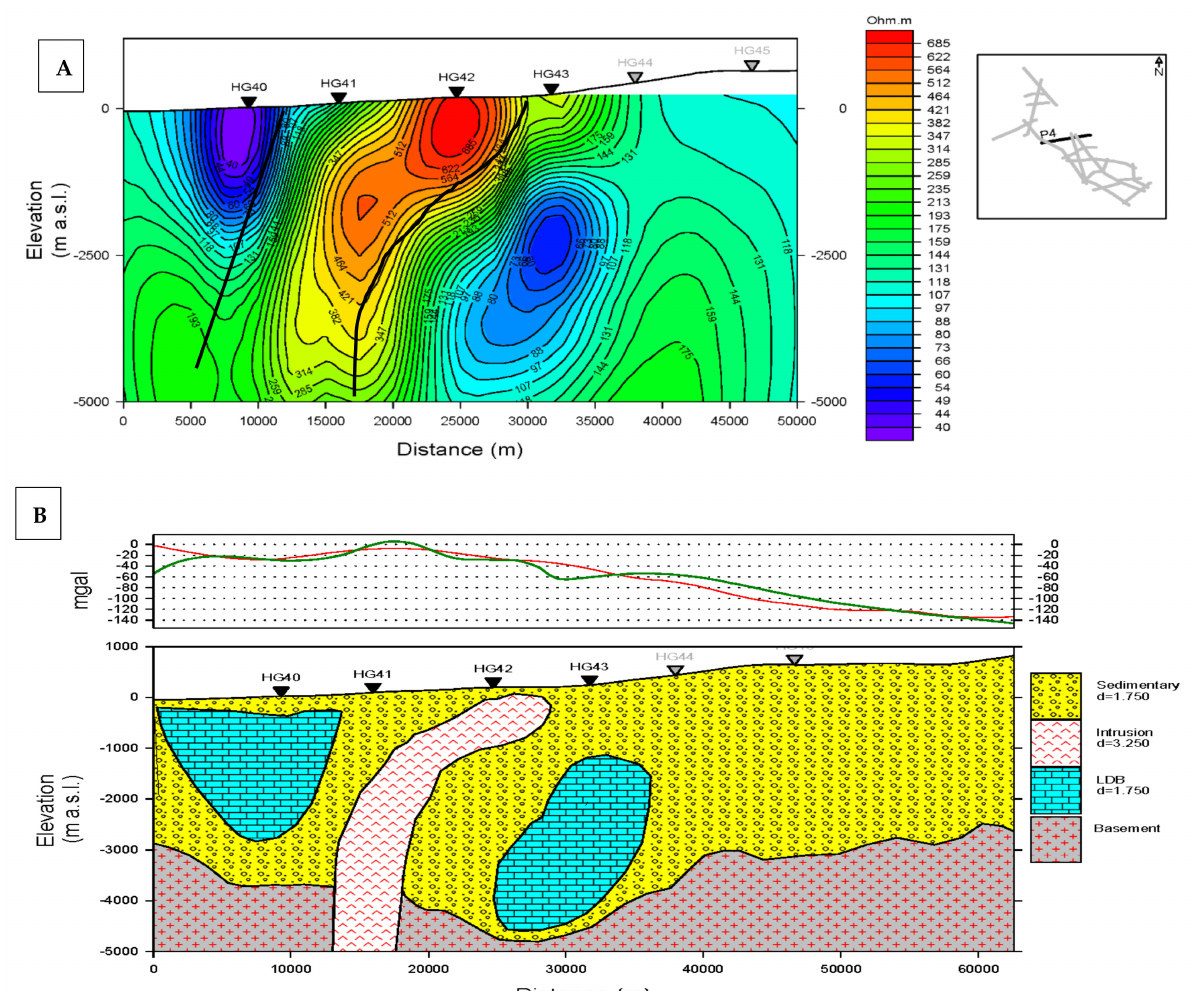
Figure 5. Profile-4 cross-sections derived from ( A ) 2D modeling of AMT data (upper panel) and ( B ) density modelling (lower